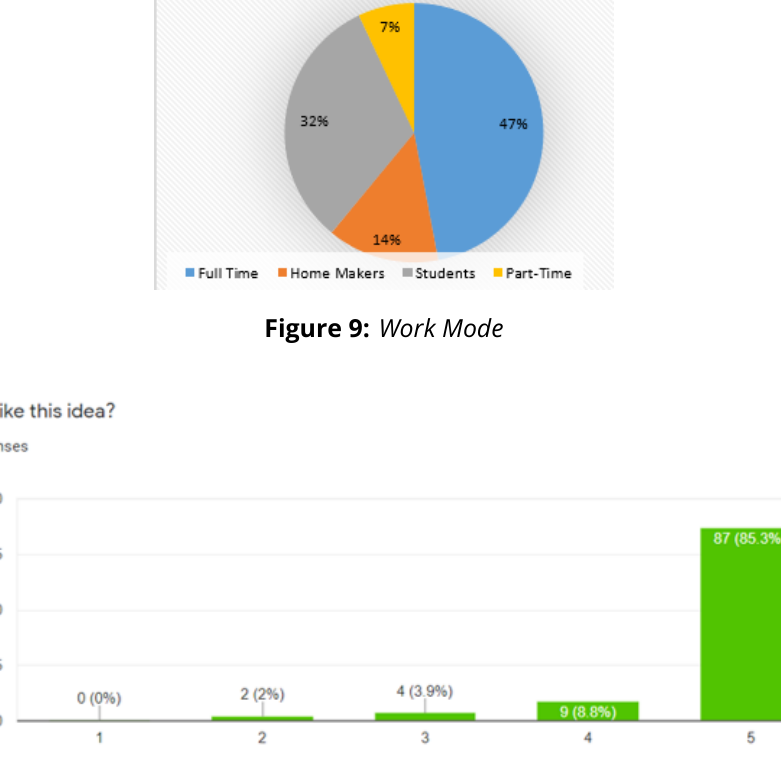
Figure 10: Likeability of the idea related to public use of Malir River Bed Forestation